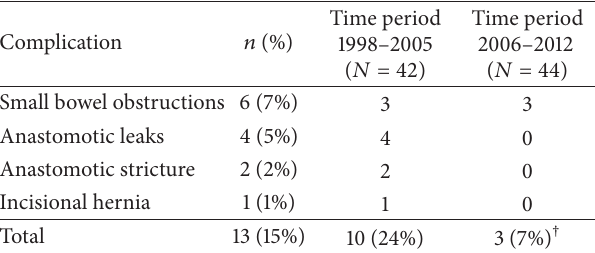
Table 4: Perioperative complications ∗